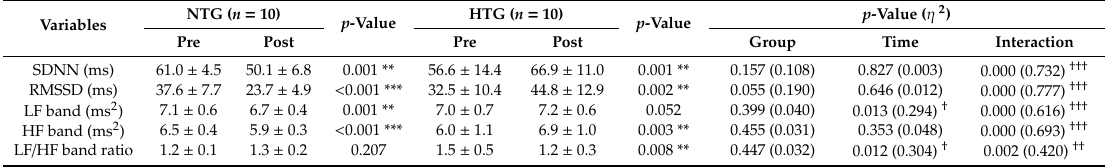
Table 4. Changes in ANS function among the competitive runners before and after the tests. Variables